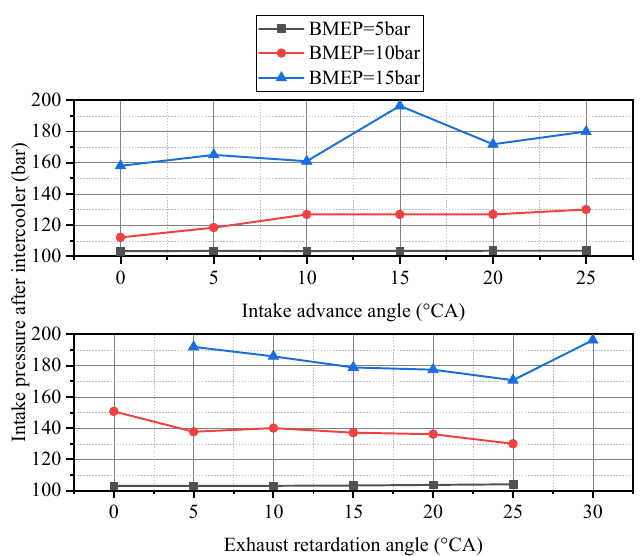
Figure 6. Intake pressure after intercooler versus intake advance angle under baseline EVC, and PMEP versus exhaust retardation angle under the Miller cycle at different points of operation during the test.